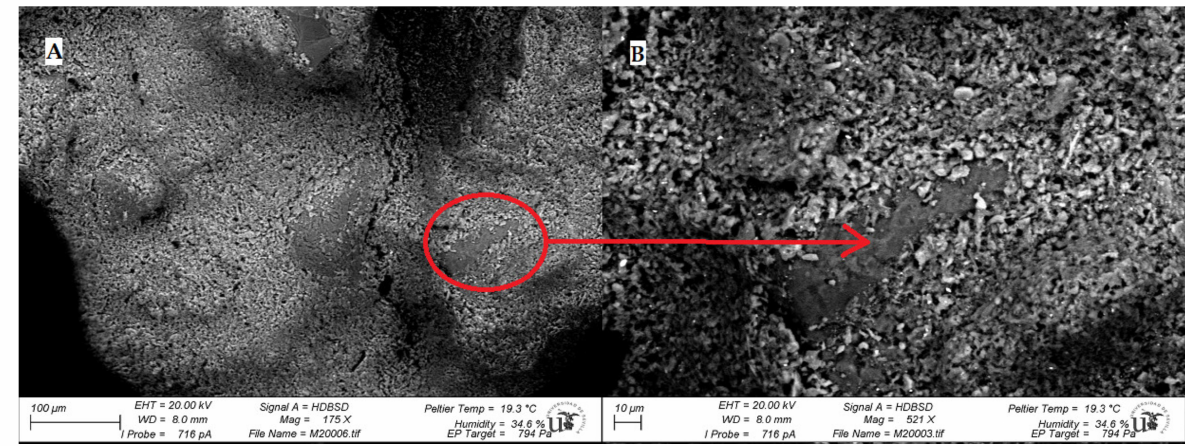
Figure 6. ( A ) SEM images of lime mortar paste (M200); ( B ) Detail of aggregate-putty